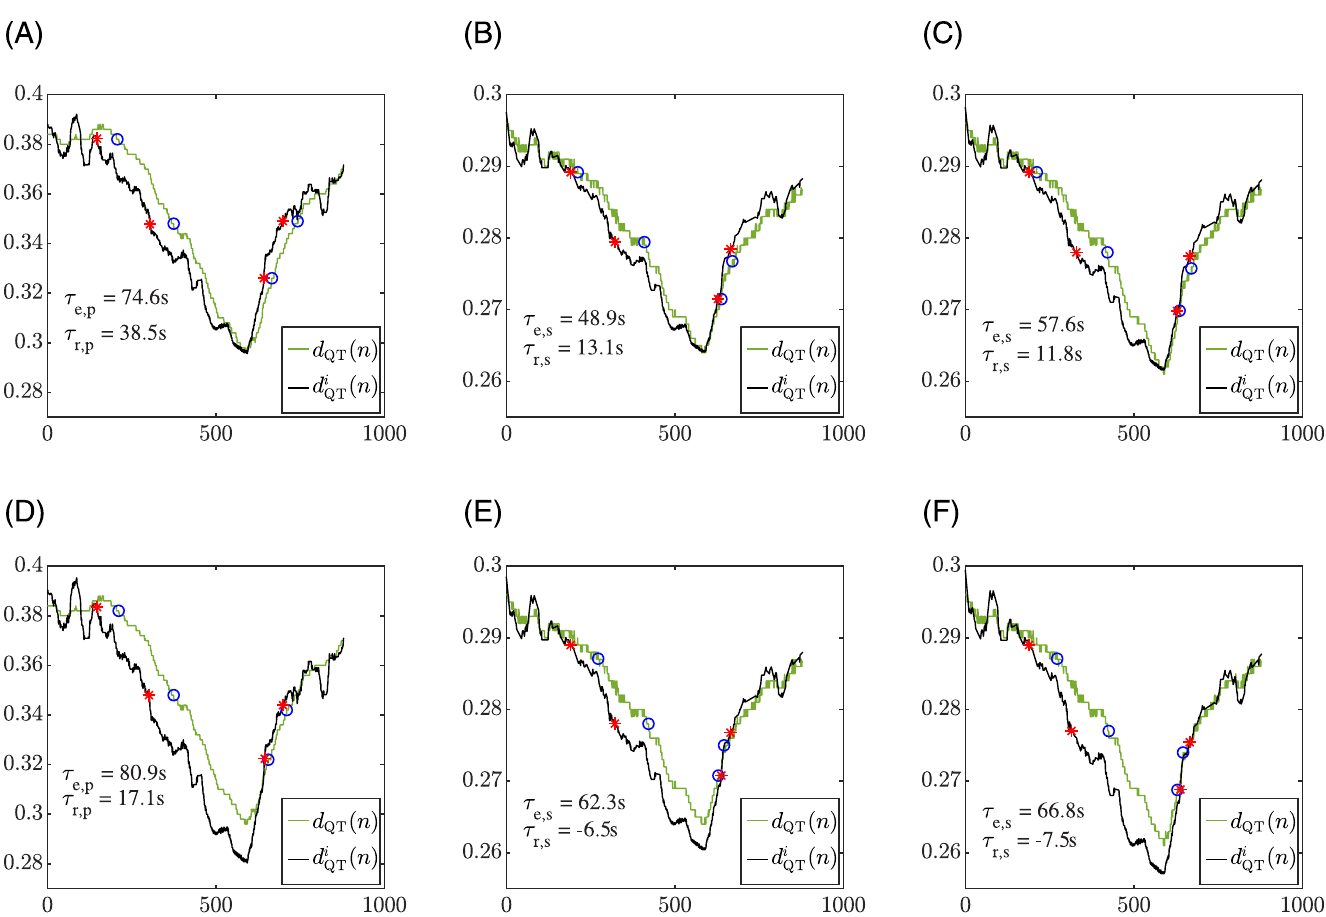
Fig 5. Left panels: QT adaptation delay between d QT ( n ) and d i ð n Þ during exercise and recovery for a patient in the study. Middle panels: QT adaptation delay between d QT ( n ) and d i ð n Þ during exercise and recovery in a simulated pECG for constant β -adrenergic stimulation and the same HR as for the patient in the left. Right panels: QT adaptation delay between d QT ( n ) and d i ð n Þ during exercise and recovery in a simulated pECG for the proposed time-varying β -adrenergic stimulation. Top panels show results using the U estimation strategy, while bottom panels use the M estimation strategy. The red points correspond to n e , o , n e , e , n r , o and n r , e , calculated as described in section 2.6, which delimit the exercise and recovery ramps in d i ð n Þ . The blue points were identified in d QT ( n ) as the nearest QT samples to the red points having QT values within 2 ms of the corresponding red point value.